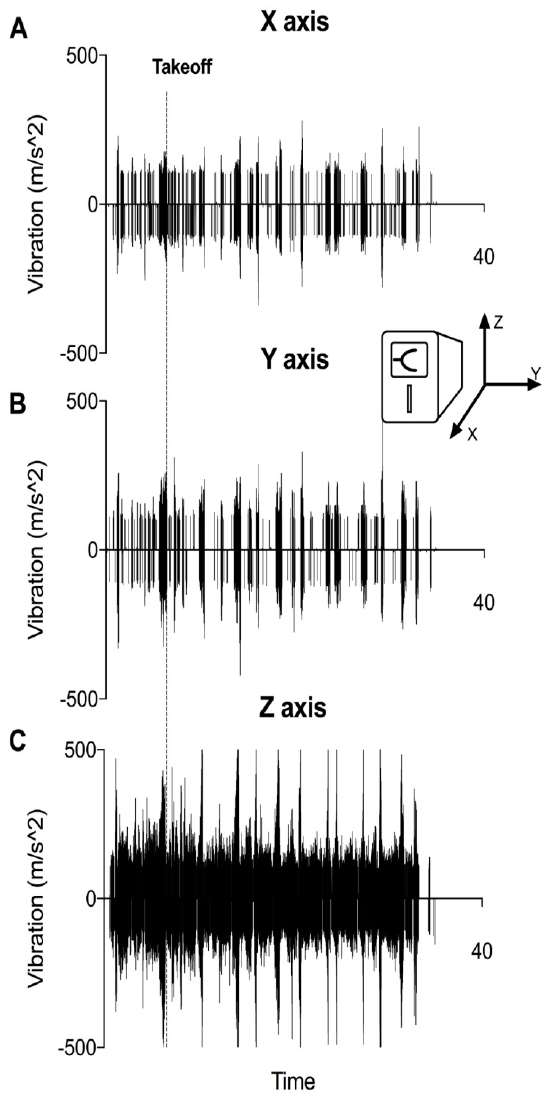
Figure 4. ( A − C ) Representative vibratometric measurement within the high ‐ vibration